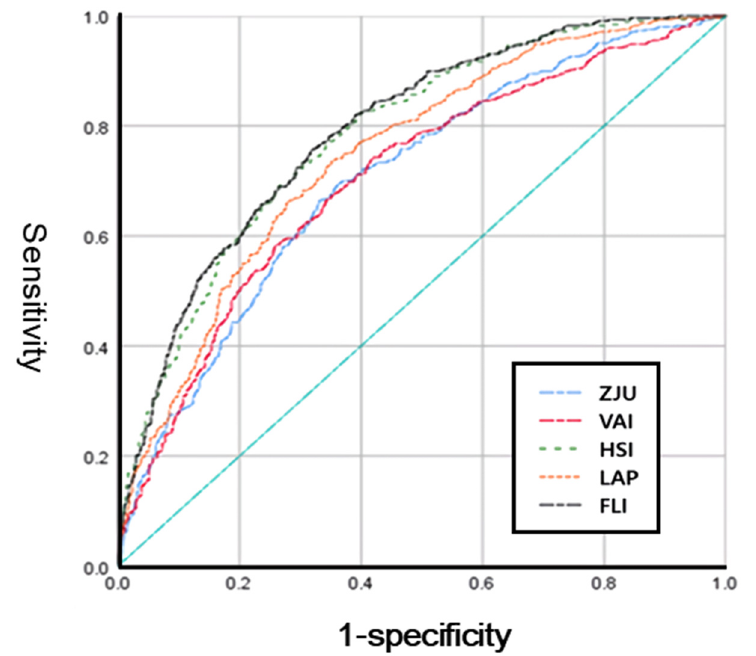
Figure 1. Receiver operating characteristic curves for ZJU (blue), VAI (pink), LAP (orange), HSI (green), and FLI (black) for identifying MAFLD. The diagonal line is the reference line. MAFLD, metabolic dysfunction-associated fatty liver disease; ZJU, Zhejiang University index; VAI, visceral adiposity index; HSI, hepatic steatosis index; LAP, lipid accumulation product; FLI, fatty liver index. Table 3. Diagnostic performances of ZJU, VAI, HSI, LAP, and FLI for detecting MAFLD.